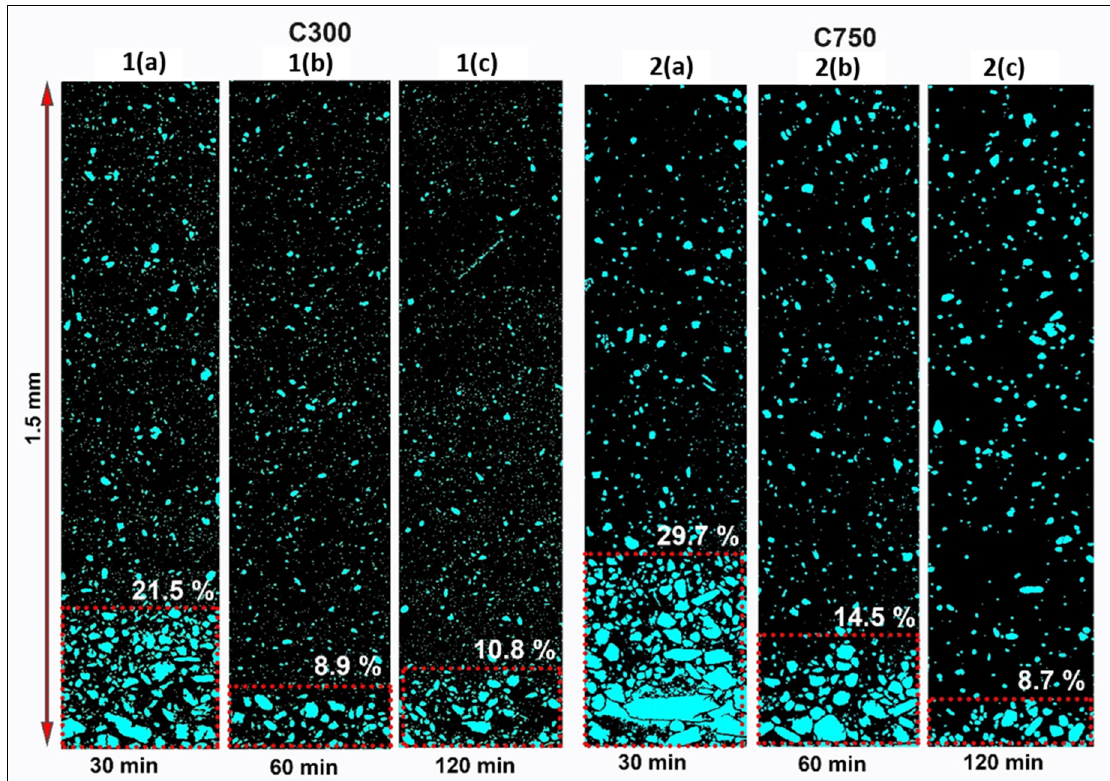
Figure 4. Coloured panoramic SEM (Stitching) images show the percentages of self-stratified GNP C300 (1) and C750 (2), applying different times of sonication 30 (a), 60 (b), and 120 min (c). The percentages indicate the height of the sedimentation layer.